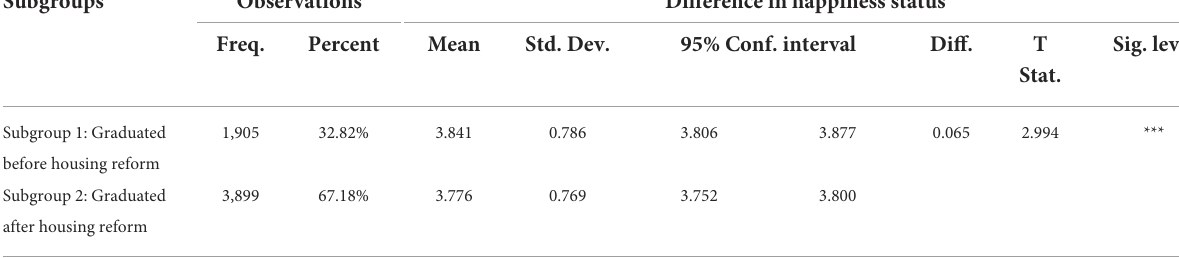
TABLE 13 Impact of housing reform on happiness of highly educated